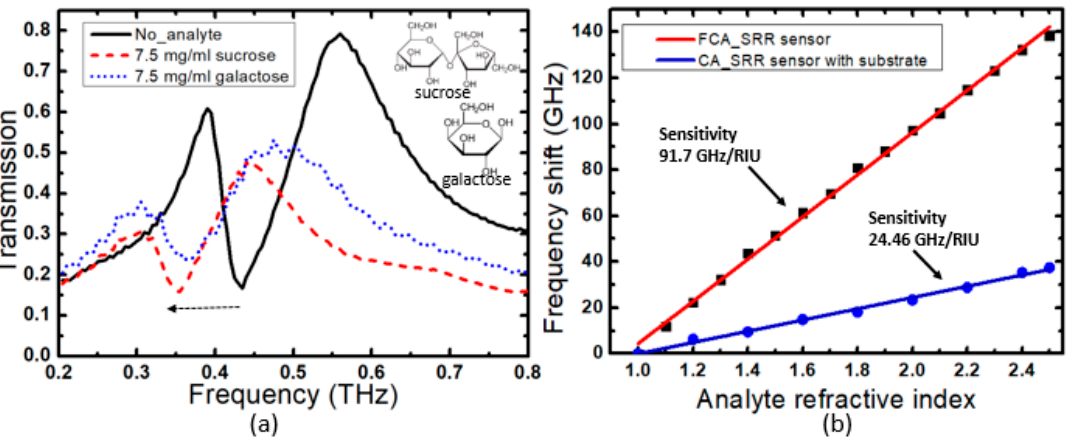
Figure 5. ( a ) Measured amplitude transmission spectra when galactose and sucrose with concentrations of 7.5 mg/mL are deposited on the sensor. ( b ) Frequency shift of the resonant frequency when sweeping the analyte refractive index at an overlayer thickness of 10 µm, for the FCA-SRR sensor (red solid line) and the CA-SRR sensor on top of silicon substrate (blue solid line).